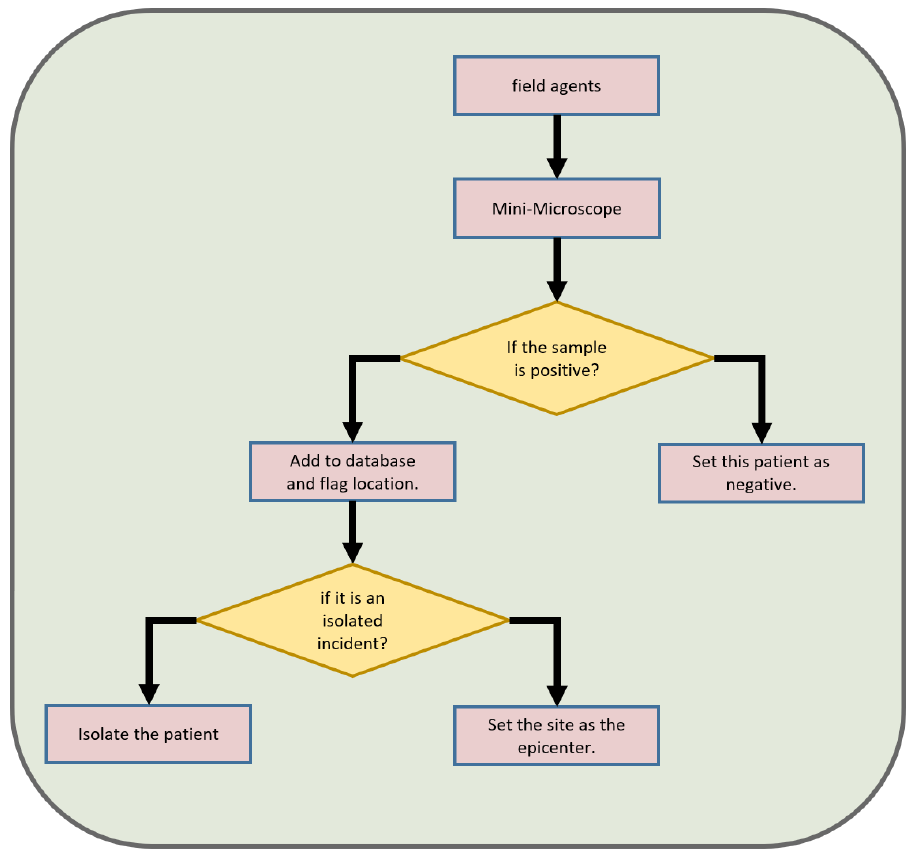
Figure 5. The described process is a system for detecting and responding to cases of malaria in a given population. It begins with field agents collecting blood samples from individuals and bringing them to a mini-microscope for analysis. The mini-microscope is a device that is capable of rapidly and accurately detecting the presence of malaria parasites in a blood sample. If the samples are found to be negative for malaria, they are labeled as such and the process is complete. However, if samples test positive for the disease, the process branches off and a decision is made based on the number of positive cases. If there is a large number of positive cases, the location is marked as an outbreak center. This indicates that there is a high prevalence of malaria in the area and that further action, such as increased efforts to control the spread of the disease, may be necessary. On the other hand, if there is just a single positive case, the person is isolated to prevent any further spread of the disease. This is particularly important in the early stages of an outbreak, as swift action can help to prevent the disease from spreading further. Overall, this system is designed to provide a fast and accurate means of detecting and responding to cases of malaria, with the goal of reducing morbidity and mortality rates associated with the